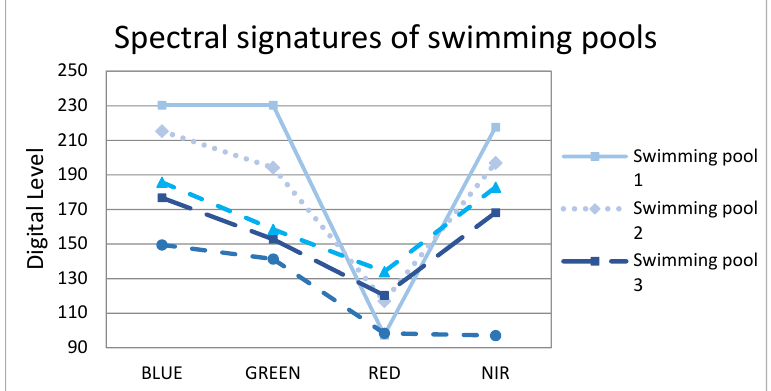
Figure 6. Spectral signatures of five swimming pools in an aerial RGB-NIR